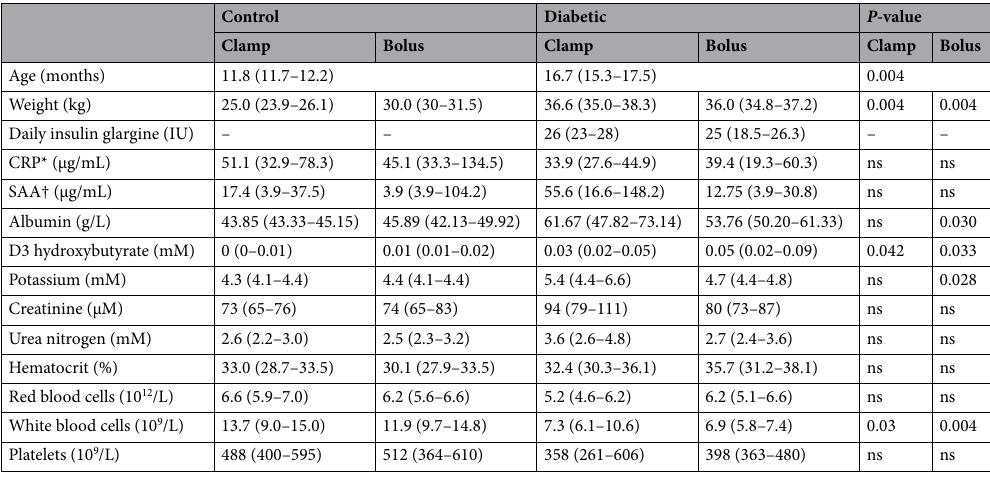
Table 1. Basal data. Selected baseline data obtained from both groups obtained at the start of studies, including age, weight, serum biomarkers and complete blood count. Data shown as medians and interquartile range. Significant difference between groups set to P < .05 and tested by Mann–Whitney U-test. *CRP = C-reactive protein, †SAA = serum amyloid